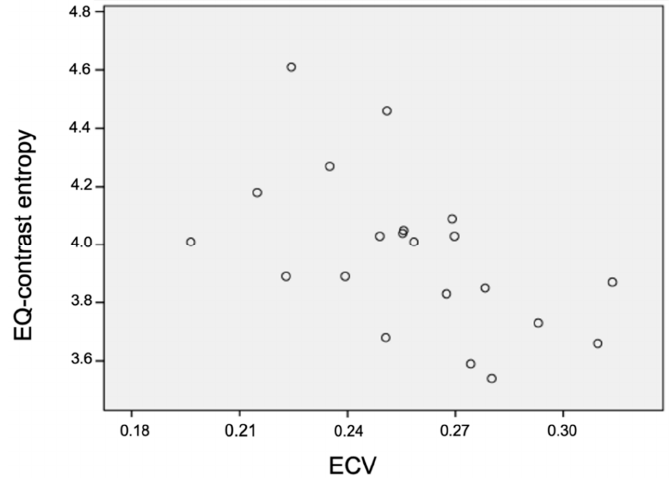
Figure 7. Scatter plot demonstrating correlation between pre-contrast standard deviation versus CPA in whole liver coarse (SSF: 6 mm) texture analysis (r s = − 0.66, p < 0.001). CPA: collagen-proportionate area; SSF: spatial space filter.